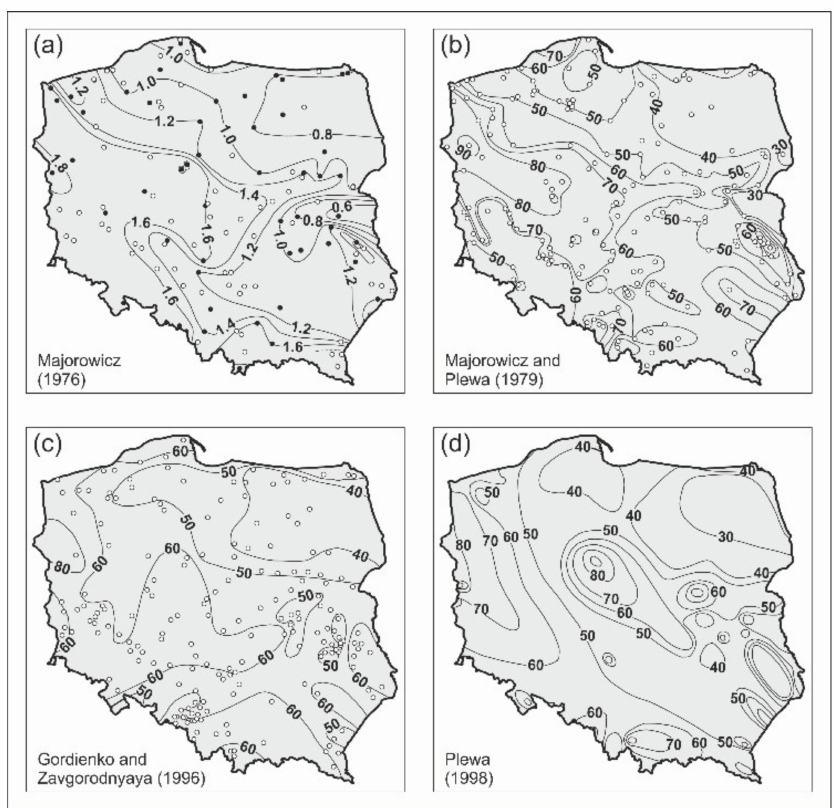
Figure 3. Historical heat flow maps of Poland according to different authors: ( a ) Majorowicz [24])–in this map Q values are in old heat flow units HFU (1 HFU = 10 − 6 cal/(cm 2 s) = 41.84 mWm − 2 ). ( b ) Majorowicz and Plewa [14]. ( c ) Gordienko and Zavgorodnyaya [11]). ( d ) Plewa [15]. For figures ( b – d ) heat flow values are in mWm − 2 . (New figure).